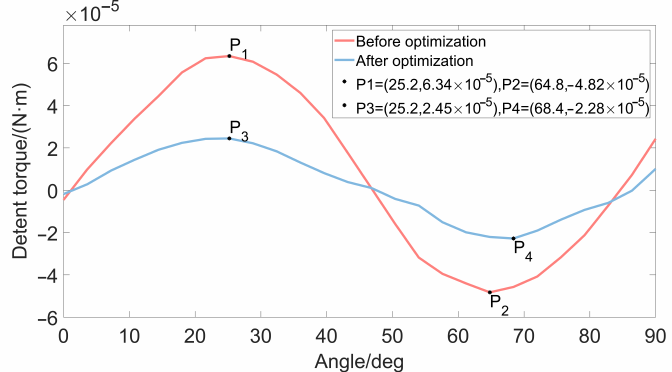
Figure 5. Comparison of detent torque before and after Taguchi analysis.